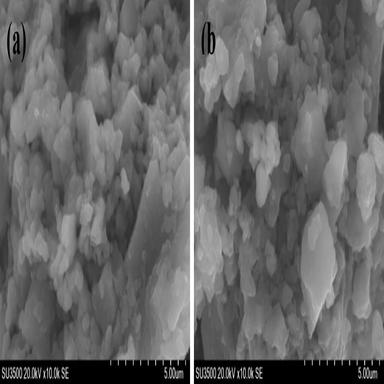
Morphology of (a) Pristine Li4Ti5O12; and (b) Li4Ti5O12 doped with Al.